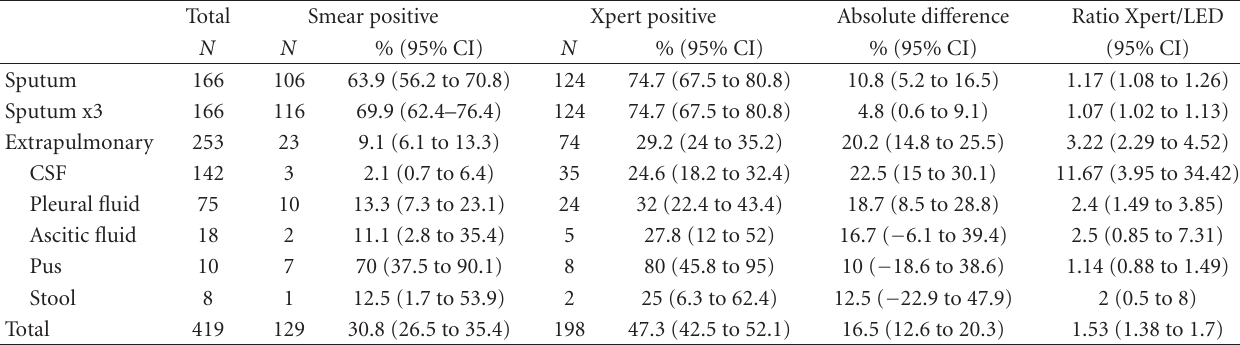
Table 2: Comparison of costs, features, and requirements of the two assays